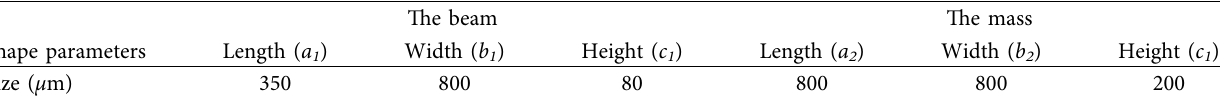
Figure 3: The structure schematic and size of Table 1: Structure parameters of the accelerometer’s beam and mass.